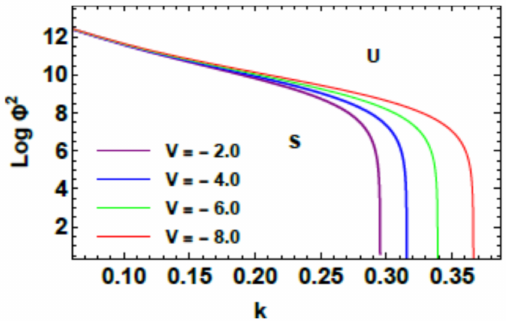
Figure 10. Plots of the stability bound for V for different values the parameter k versus Log Φ 2 .